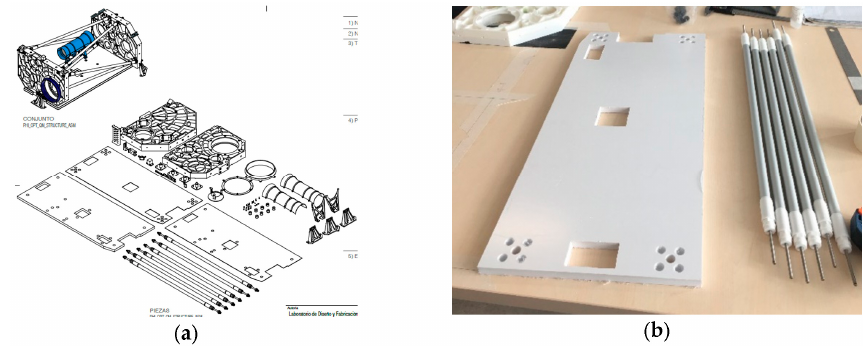
Figure 10. ( a ) Plane of the instrument base. ( b ) Base of the instrument and reinforcement